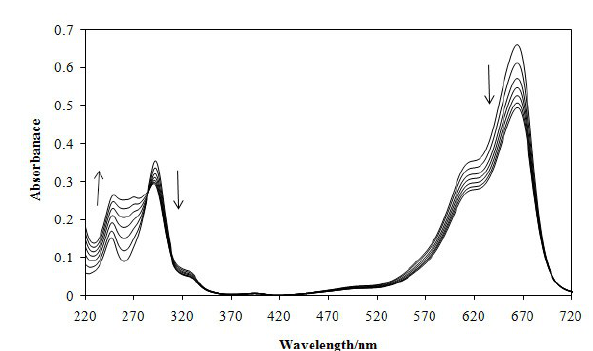
Figure 4. Absorption spectra of MB in the presence of DNA at different concentrations. ＝ 0.0, 5.3, 10.0, 14.8, 19.1, 23.0 and 26.7 μmol L -1 for curves 1-7, and C C DNA